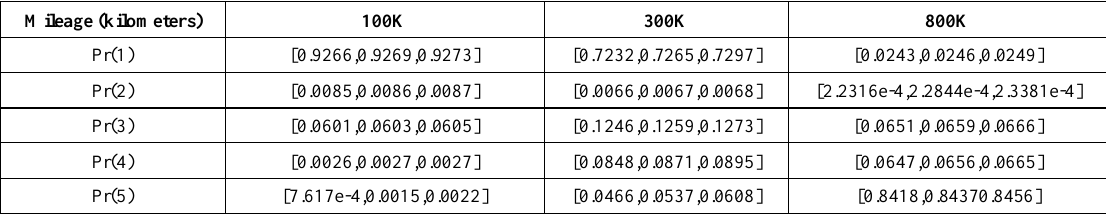
Fuzzy system state probabilities with changing